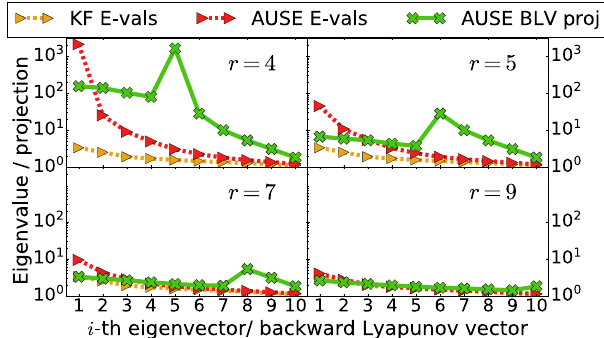
Figure 1. Eigenvalues of the KF and KF-AUSE forecast error co- variance plotted with triangles. Projection coefficients of the KF- AUSE forecast error covariance plotted with crosses. Dimension of the KF-AUSE filtered subspace is r . Note the log scale of the y